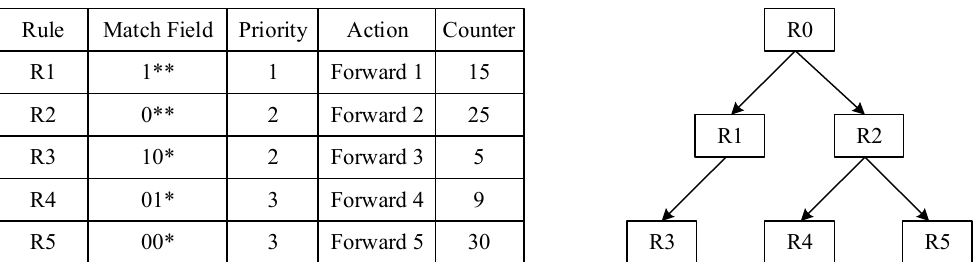
Figure 1. An example of rule dependency. Each rule is represented as a node in the graph. * is a wildcard character. ** are two wildcard characters.